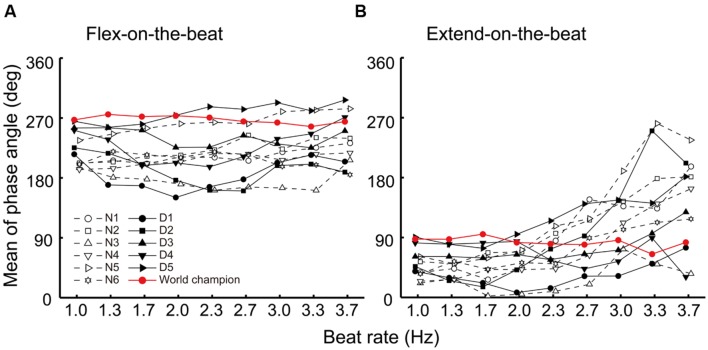
Mean phase angle of the movement trajectory at the beat time under the flex-on-the-beat (A) and the extend-on-the-beat (B) conditions. The data were plotted for each participant. The dashed line denotes the non-dancers, the solid line denotes the dancers, and the red line denotes the world champion.